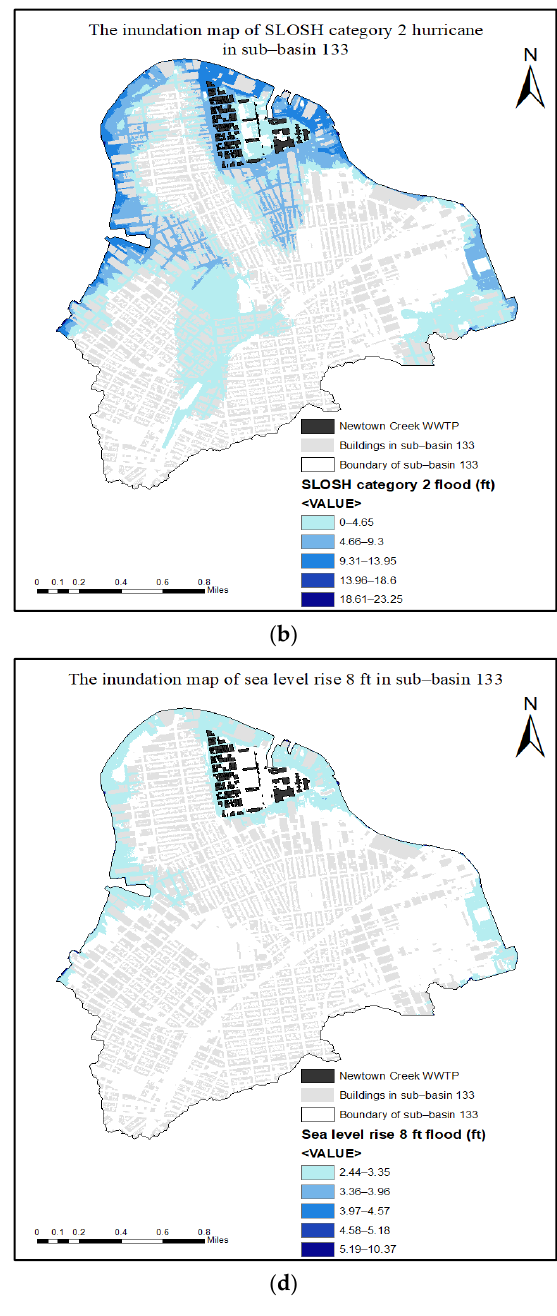
Figure 3. ( a ) Land cover of sub-basin 133 in NYC, ( b – d ) inundation maps of SLOSH category 2 hurricane, a rainfall of 10.9 cm/h for 20 min, and sea level rise of 2.44 m (8 ft) in sub-basin 133.